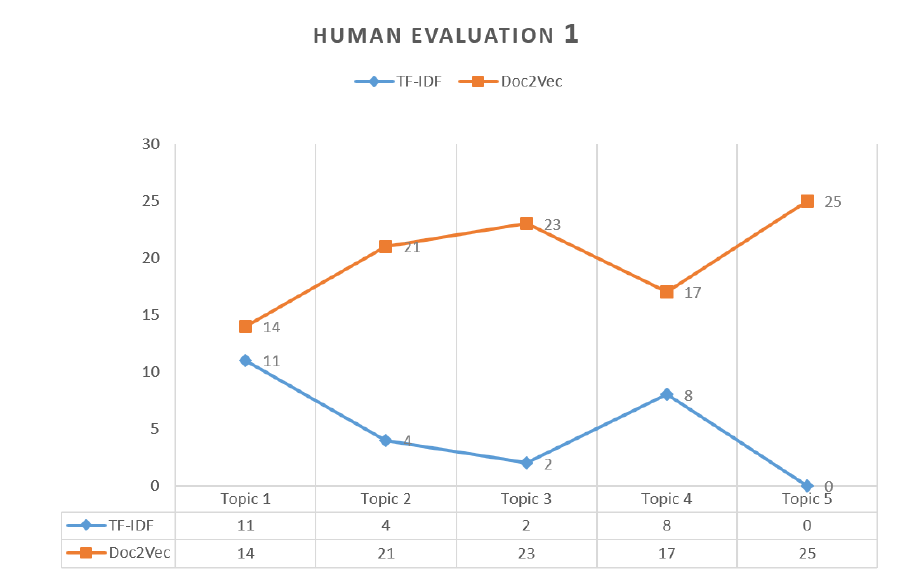
Figure 16. Effect Comparison Between TF-IDF and